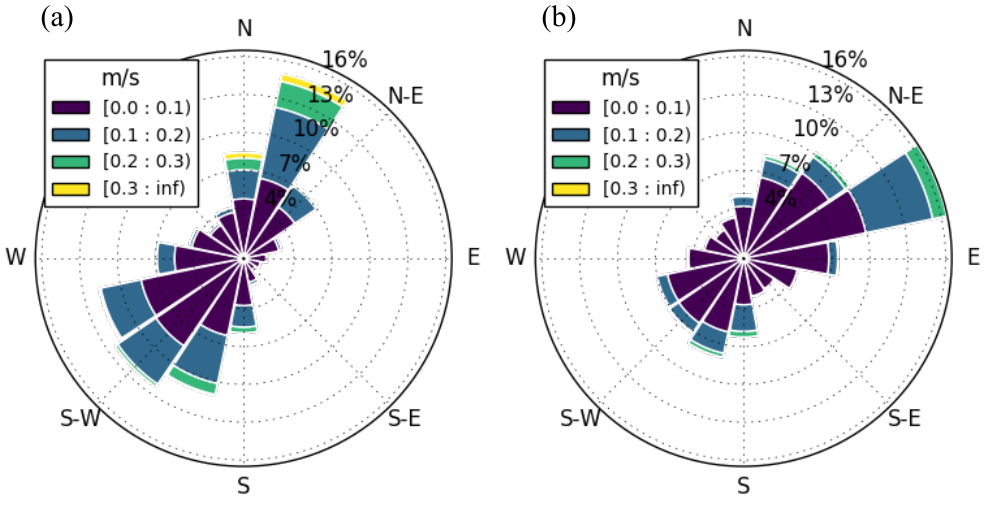
Figure 3. Current rose from measurements at 5 m depth ( a ) and at 38 m depth ( b ). Current direction is given as the direction where the flow is going to.